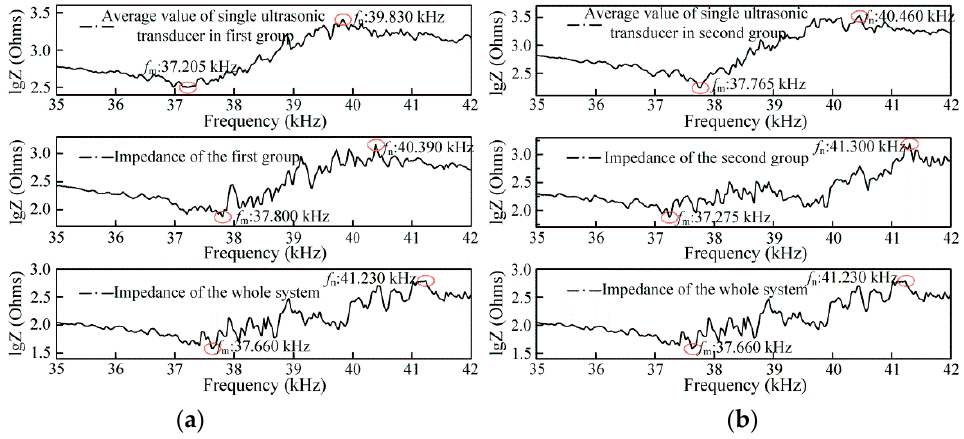
Figure 10. Impedance curves of the ultrasonic transducers under different conditions. ( a ) First group of ultrasonic transducers; ( b ) second group of ultrasonic transducers.